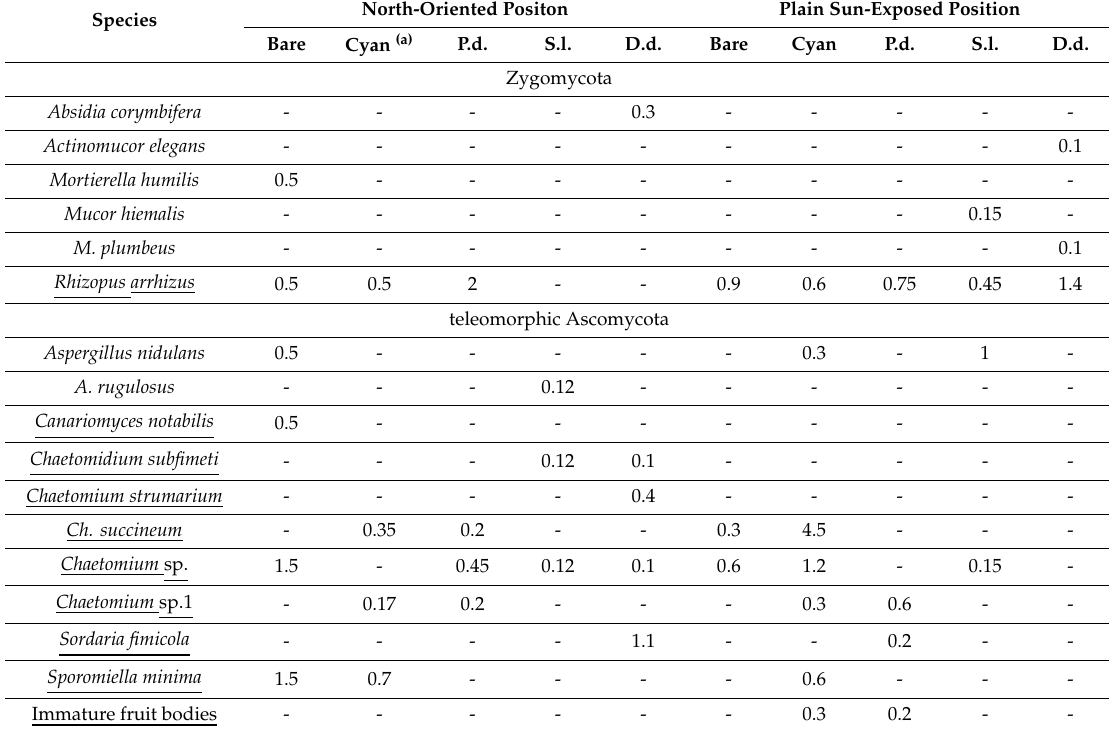
Table 1. Microfungi in different crust types and bare surface at the Tabernas Desert, with their average relative abundance (%). Underlined species are melanin-containing.